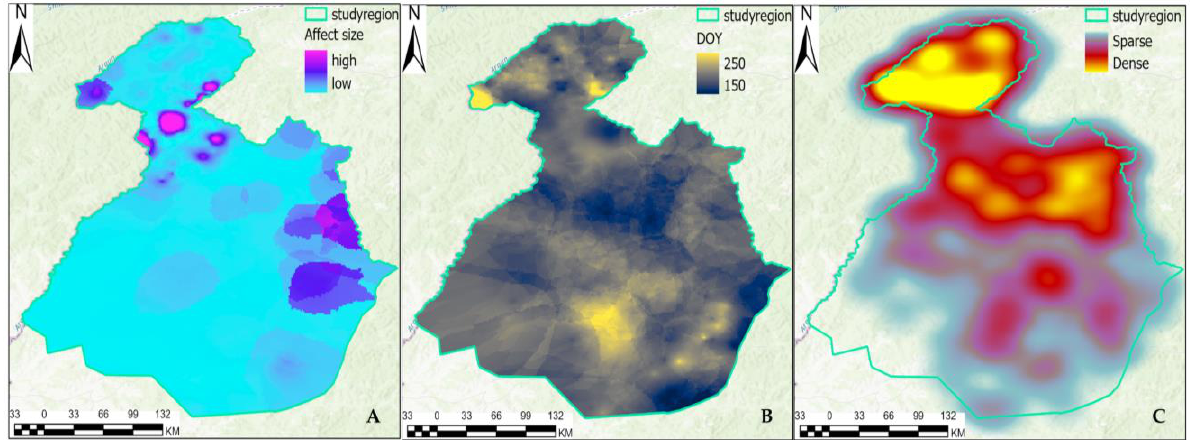
Figure 4. Lightning-fire distribution: ( A ), rasterized lightning-fire-affected area; ( B ), rasterized lightning-fire DOY (day of the year) distribution; ( C ), rasterized lightning-fire density.